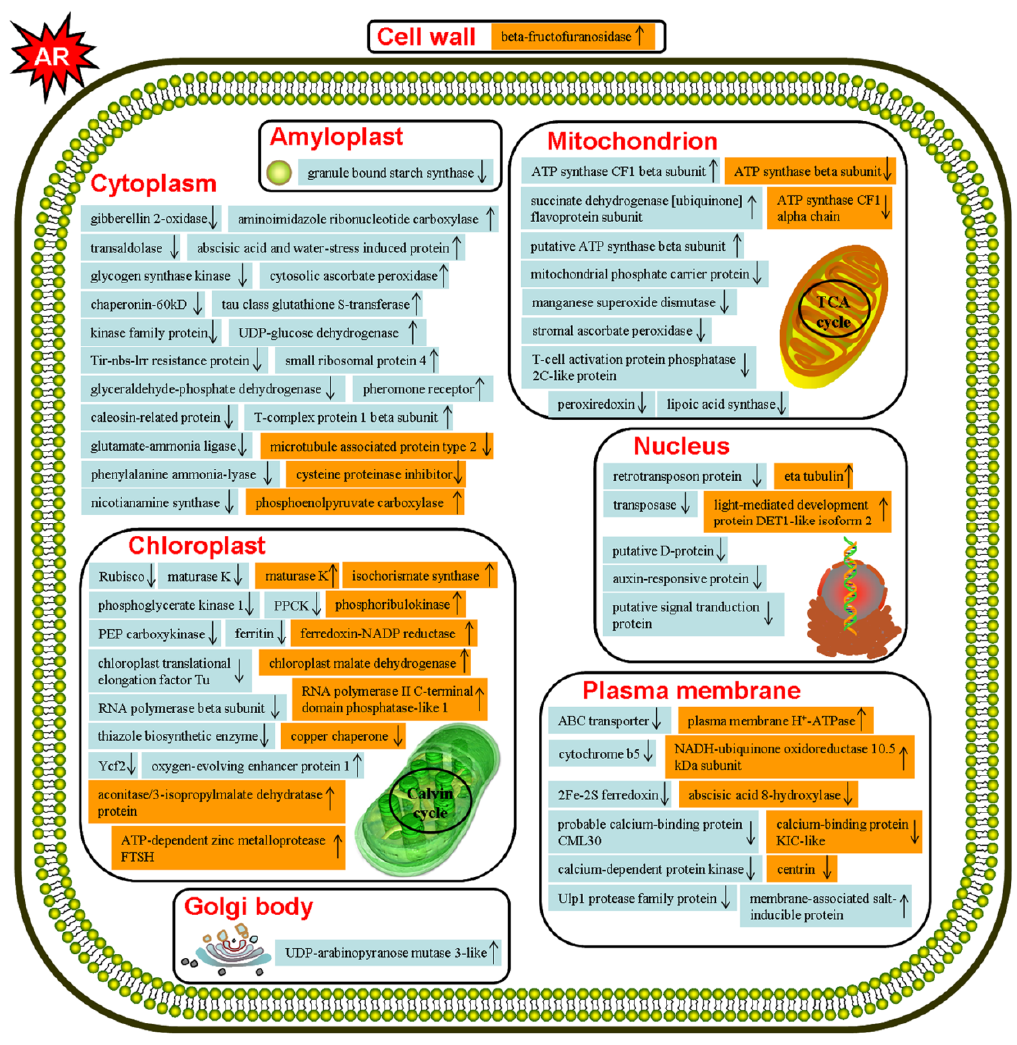
Figure 4. Putative subcellular location model of AR stress response in P. massoniana and T. wallichinana var. mairei . The proteins marked in blue or orange represents they were found in P. massoniana or T. wallichinana var. mairei , respectively. Some of the AR-responsive proteins are indicated with those up-regulated marked by ↑ and those down-regulated marked by ↓ . The abbreviations used in the Figure were explained in Tables 1 and